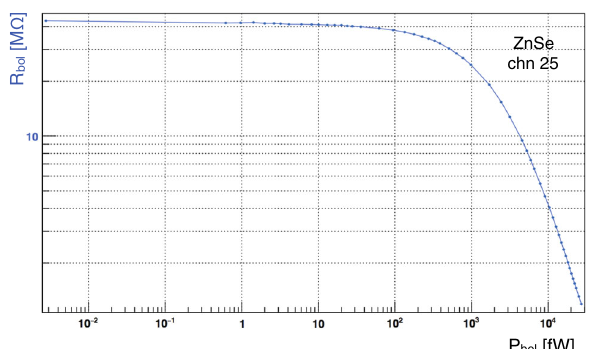
Fig. 23 Characteristic load curve of a CUPID-0 ZnSe crystal oper- ated with a Ge-NTD thermal sensor. The figure shows how a Ge-NTD stands high power dissipation without affecting the sensor operational conditions